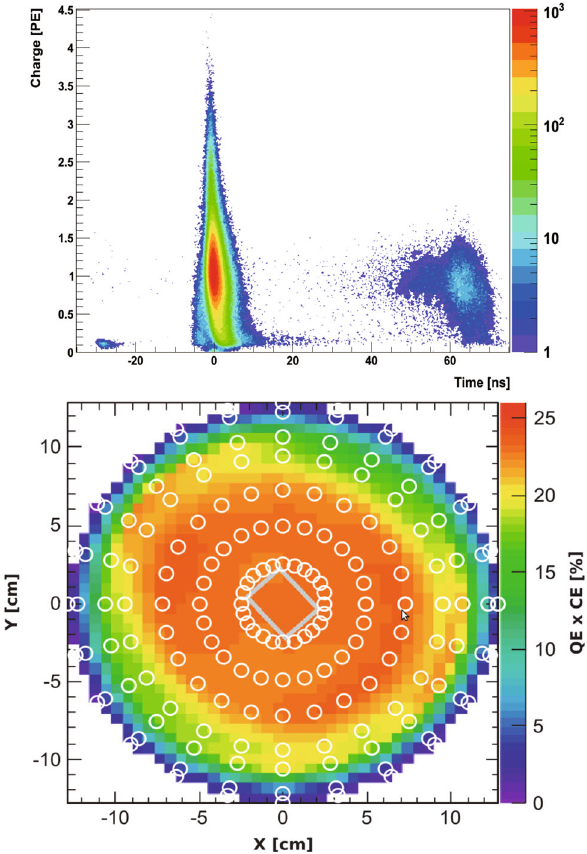
Fig. 21 Transit time versus charge plotted event by event [39] (top). One can identify main pulses around t = 0ns with a transit time spread of ≈ 3ns,pre-pulsesaround t = − 25nsandlate-pulsesupto t = 70ns. The fraction of single PE in the measured population was about 95%